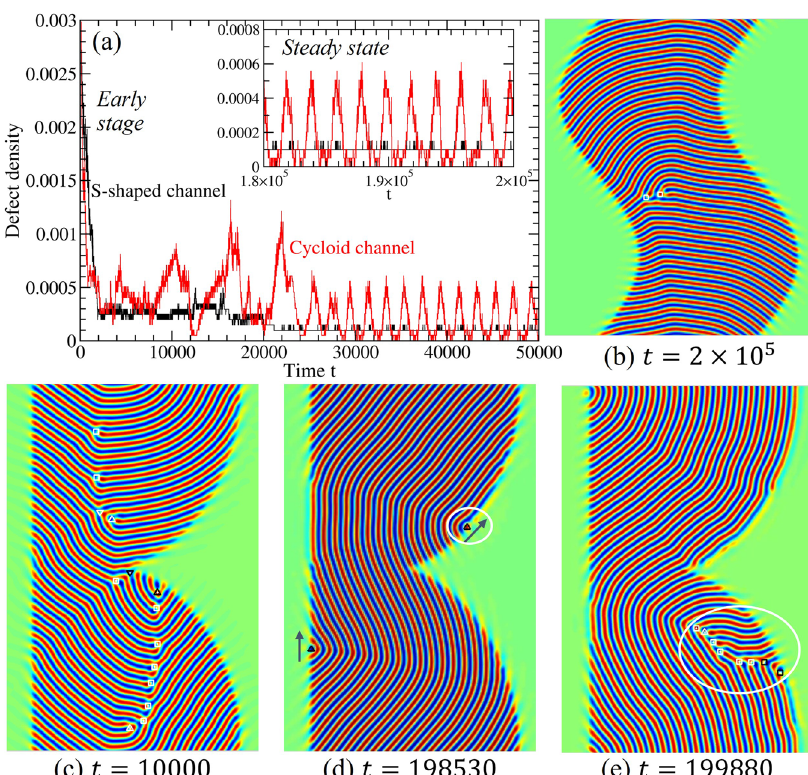
Fig. 6 Time evolution of defects in open channels. a Time evolution of defect number density in two types of open channels at v 0 = 0.31 (with periodic boundary condition along the vertical open ends). b – e Snapshots of ψ pro fi les at different times for ( b ) S-shaped and ( c – e ) cycloid channels.